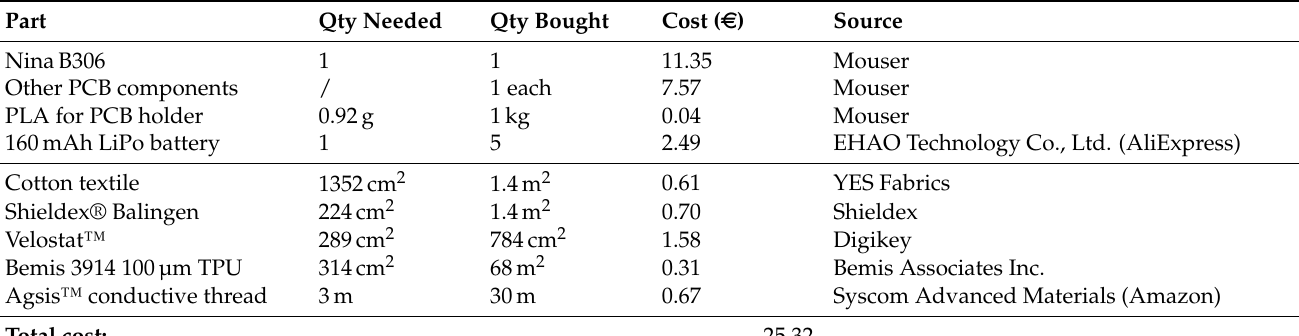
Table 2. Cost calculation for a single smart textile as of October 2021. Prices are based on a certain quantity bought, reported in the respective column. The total price excludes PCB manufacturing.